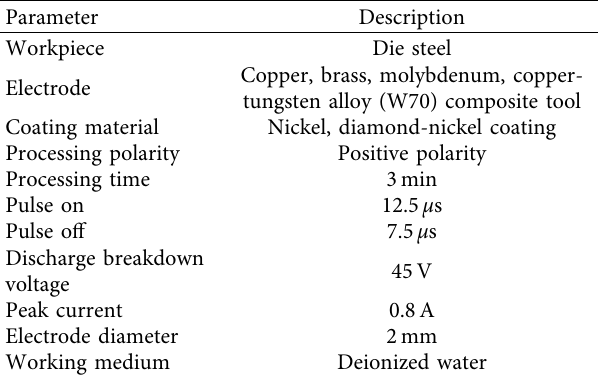
Table 5: Electrode experimental parameters in EDM.